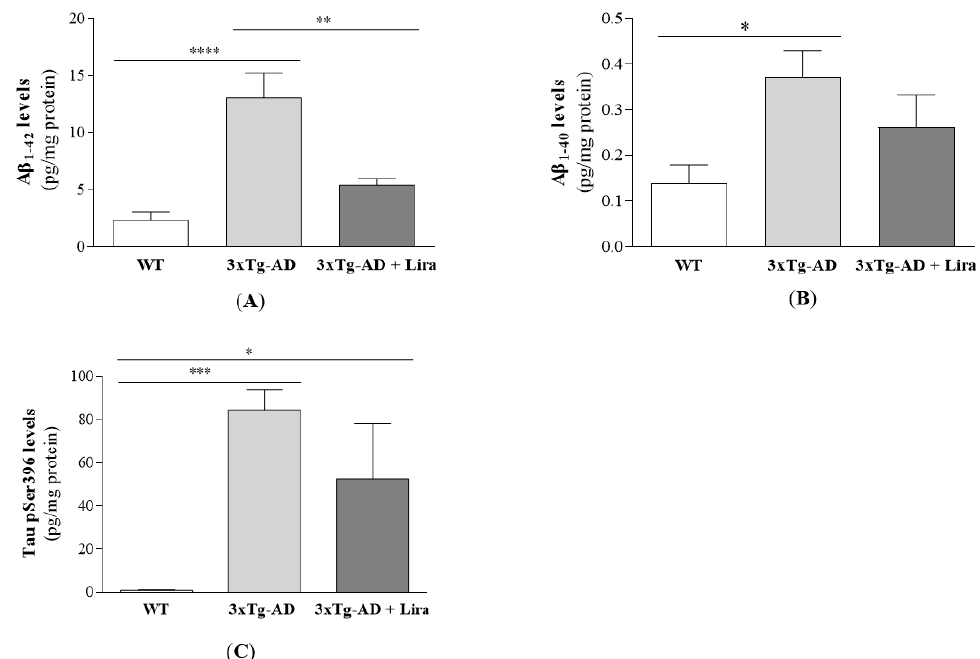
Figure 1. Effect of liraglutide on brain cortical AD-like hallmarks in 3xTg-AD female mice. Brain cortical Aβ 1–42 ( A ), Aβ 1–40 ( B ) and Tau pSer396 levels ( C ) were determined. Data are the mean ± SE from 4–6 mice/group. Statistical significance: * p < 0.05, ** p < 0.01, *** p < 0.001 or **** p < 0.0001, by the one-way ANOVA with the Bonferroni and Fisher LSD post-hoc tests for multiple comparisons.